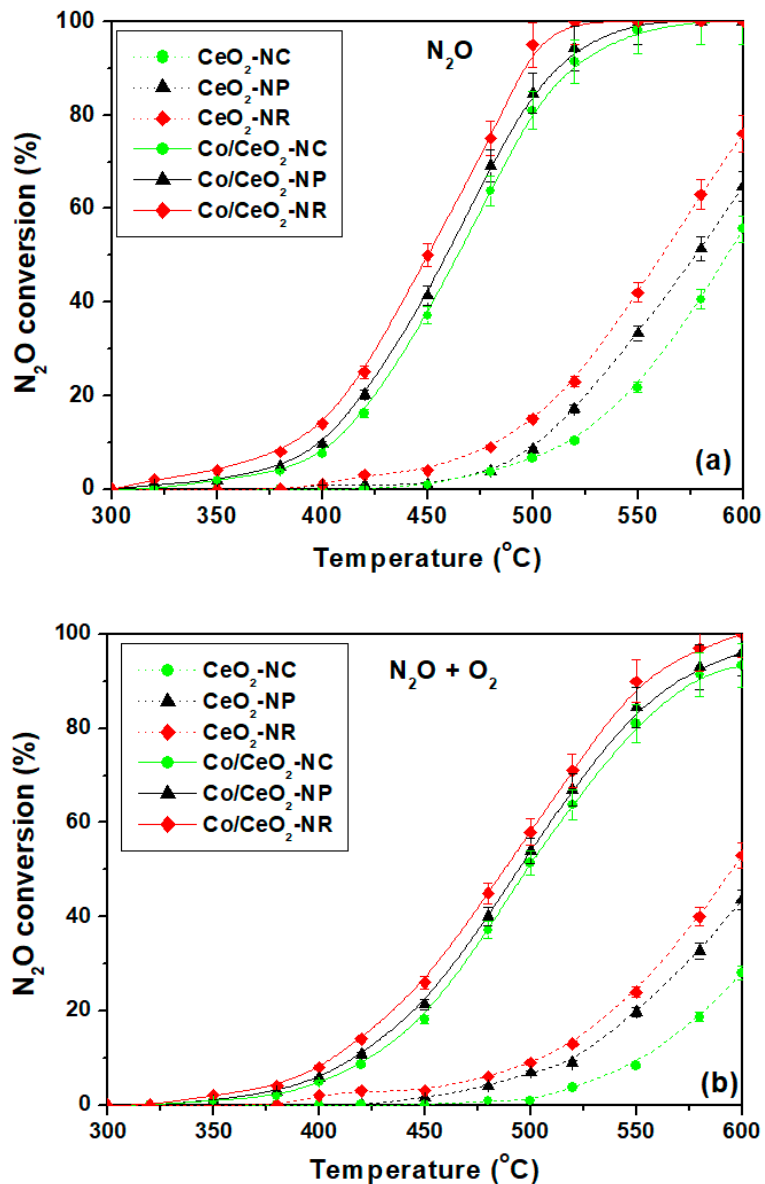
Figure 7. N 2 O conversion as a function of temperature for CeO 2 and Co/CeO 2 samples of different morphology ( a ) in the absence and ( b ) in the presence of oxygen: The reaction conditions are 1000 ppm N 2 O, 0 or 2% O 2 and Gas Hour Space Velocity (GHSV) = 40,000 h − 1 .